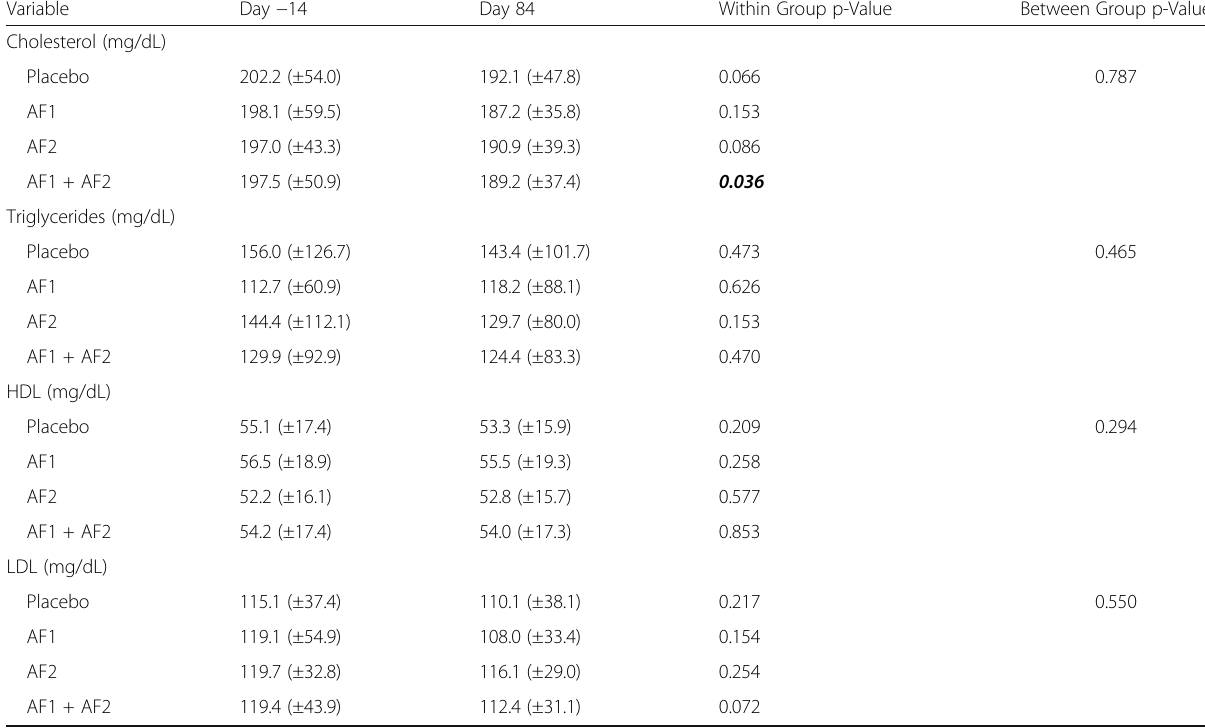
Table 11 Changes in lipid measures from day − 14 to day 84 Variable Within Group p-Value Between Group p-Value Cholesterol